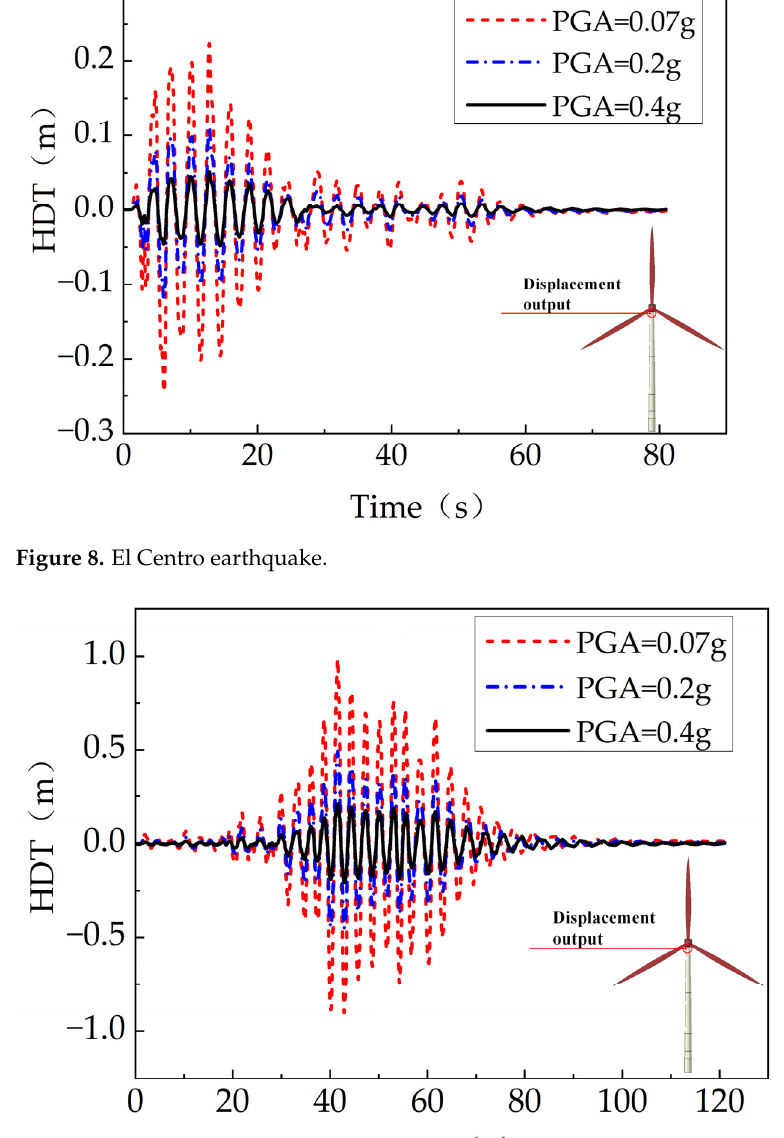
Figure 9. Nihonkai-Chubu earthquake.